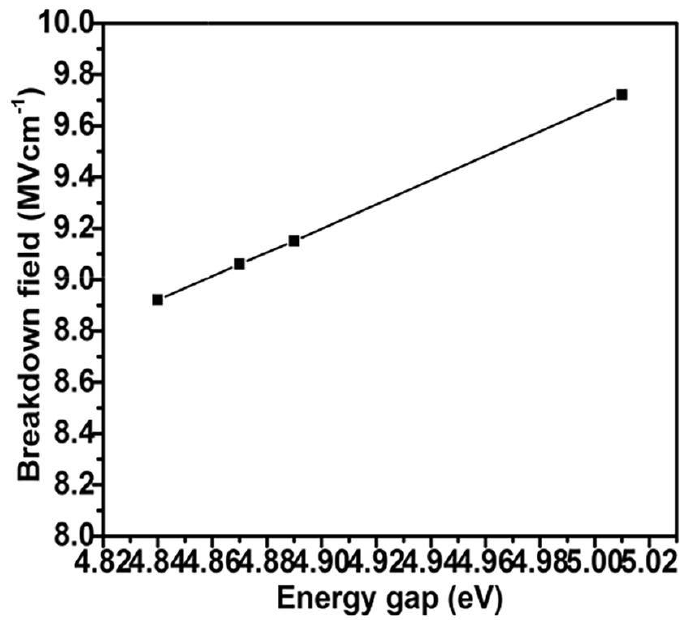
Figure 17. The plotted graph of enhanced E c for beta gallium oxide microstructures [194]. “Reprinted with permission from Ref. [194]. Copyright (2019), Elsevier.”.